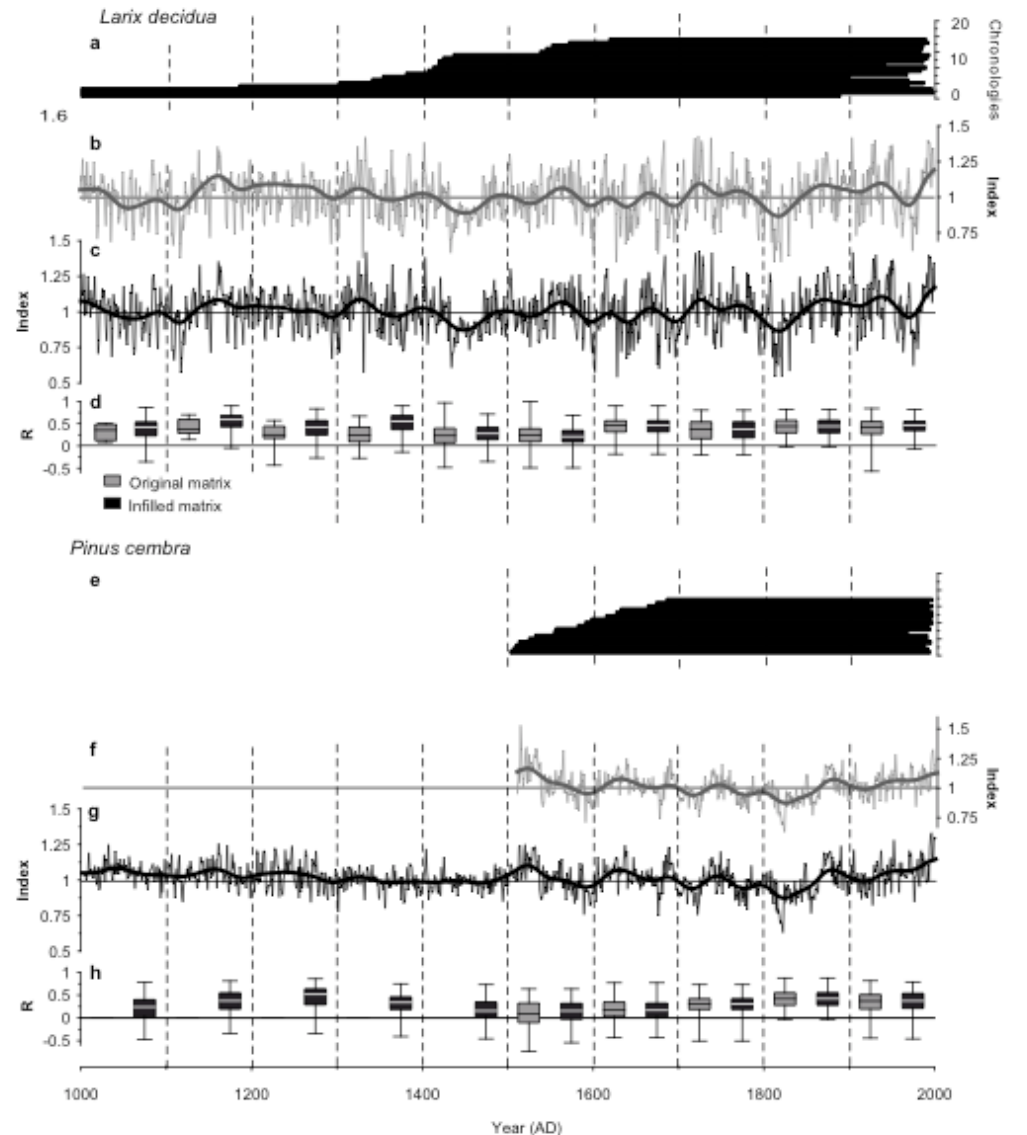
Fig. 3. Adaptative Regional Growth Curve (ARGC) detrended alpine chronologies and signal robustness. (a) , (e) , distribution of the chronologies with each bar representing a single chronology. The alpine larch (b) , (c) and pine (f) , (g) ARGC detrended chronologies are calculated for original (b, f, grey) and infilled (c, g, black) matrixes. The thick lines derive from 20-years low-pass filtering. The box-plots Figure 3. Adaptative Regional Growth Curve (ARGC) detrended alpine chronologies and (d) , (h) display the mean correlations computed for 100-years segments in each matrix. signal robustness. (a), (e), distribution of the chronologies with each bar representing a single About the detrending methods, several reconstructions of chronology. The alpine larch (b), (c) and pine (f), (g) ARGC detrended chronologies are summer temperatures using independent datasets and both individual spline fits and RCS techniques (B¨untgen et al., calculated for original ((b), (f), grey) and infilled ((c), (g), black) matrixes. The thick lines 2005, 2006a; Casty et al., 2005; Frank and Esper, 2005) similarly underestimated the early instrumental data. This derive from 20-years low-pass filtering. The box-plots (d), (h) display the mean correlations discrepancy also appears in this study even with the new de- computed for 100-years segments in each matrix trending ARGC technique. It is then not likely that these sys- tematic discrepancies can be explained by